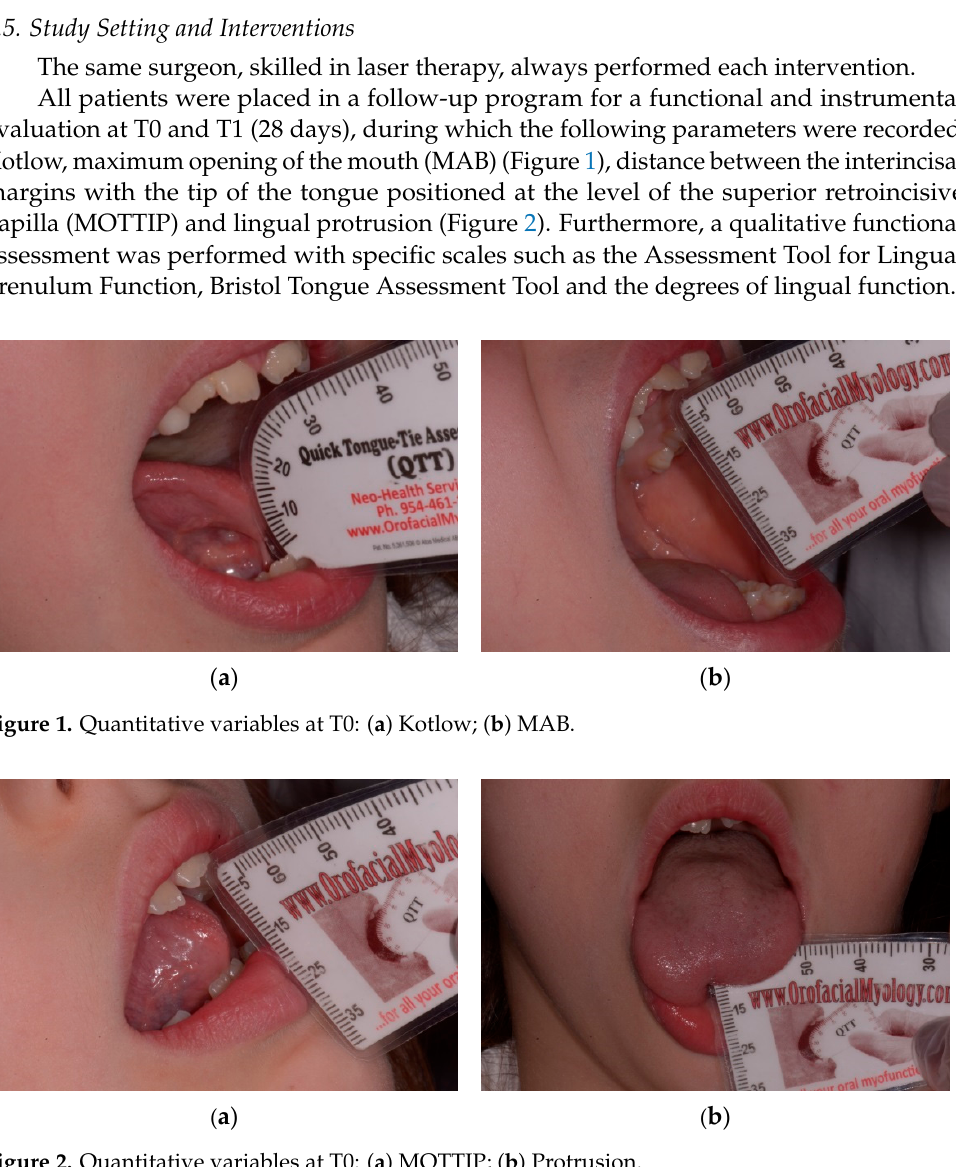
Table 3. Setting of the device.